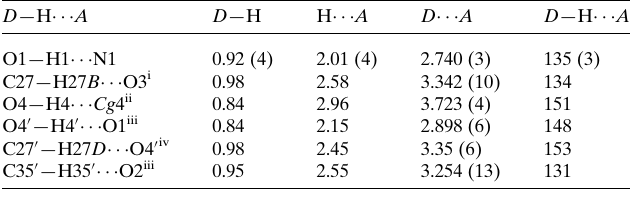
Table 1 Hydrogen-bond geometry (A˚ , (cid:3)